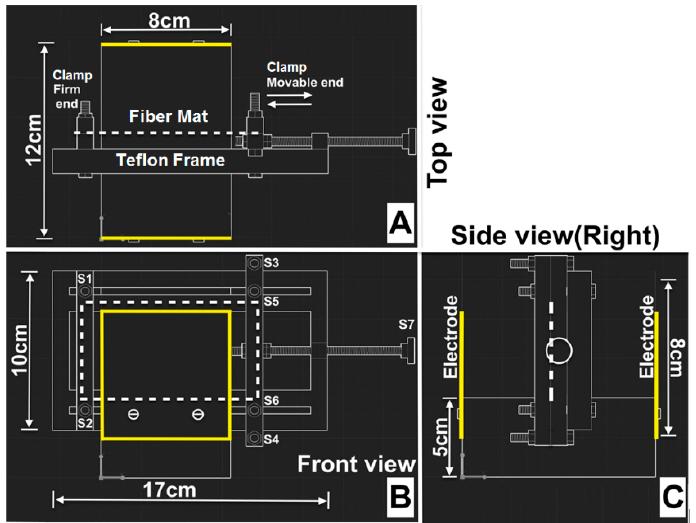
Figure 2. Perspective views of custom-made polarization device designed using Autodesk®-AutoCAD®-2015. Orientation of the electrospun fiber mat is indicated by the dotted white lines and aluminum electrodes are indicated by solid yellow lines. Copyright reprints from [18].